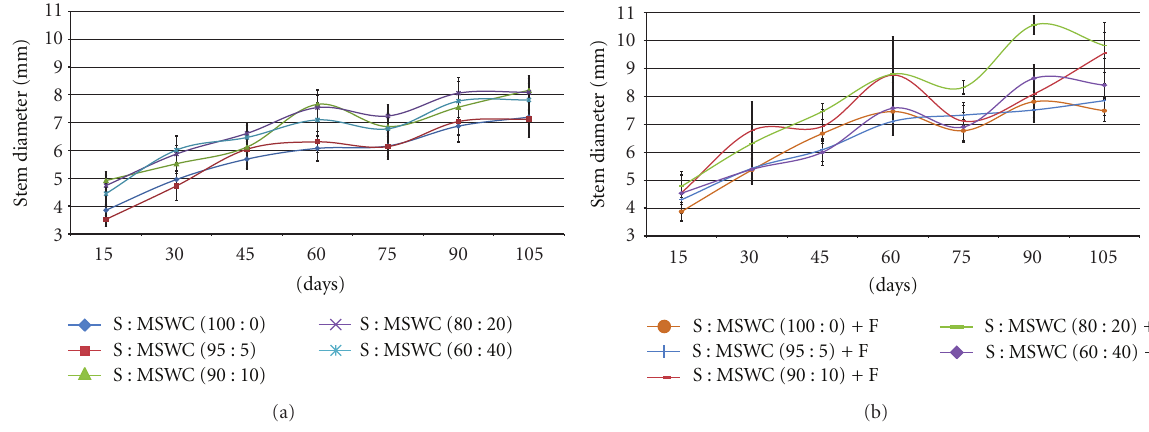
Figure 2: E ff ects of municipal solid waste compost (MSWC) into soil (S) without (a) or with (b) fertigation (F) on stem diameter of greenhouse pepper crop. Values represent mean ( ± SE) of measurements made on six plants per treatment.